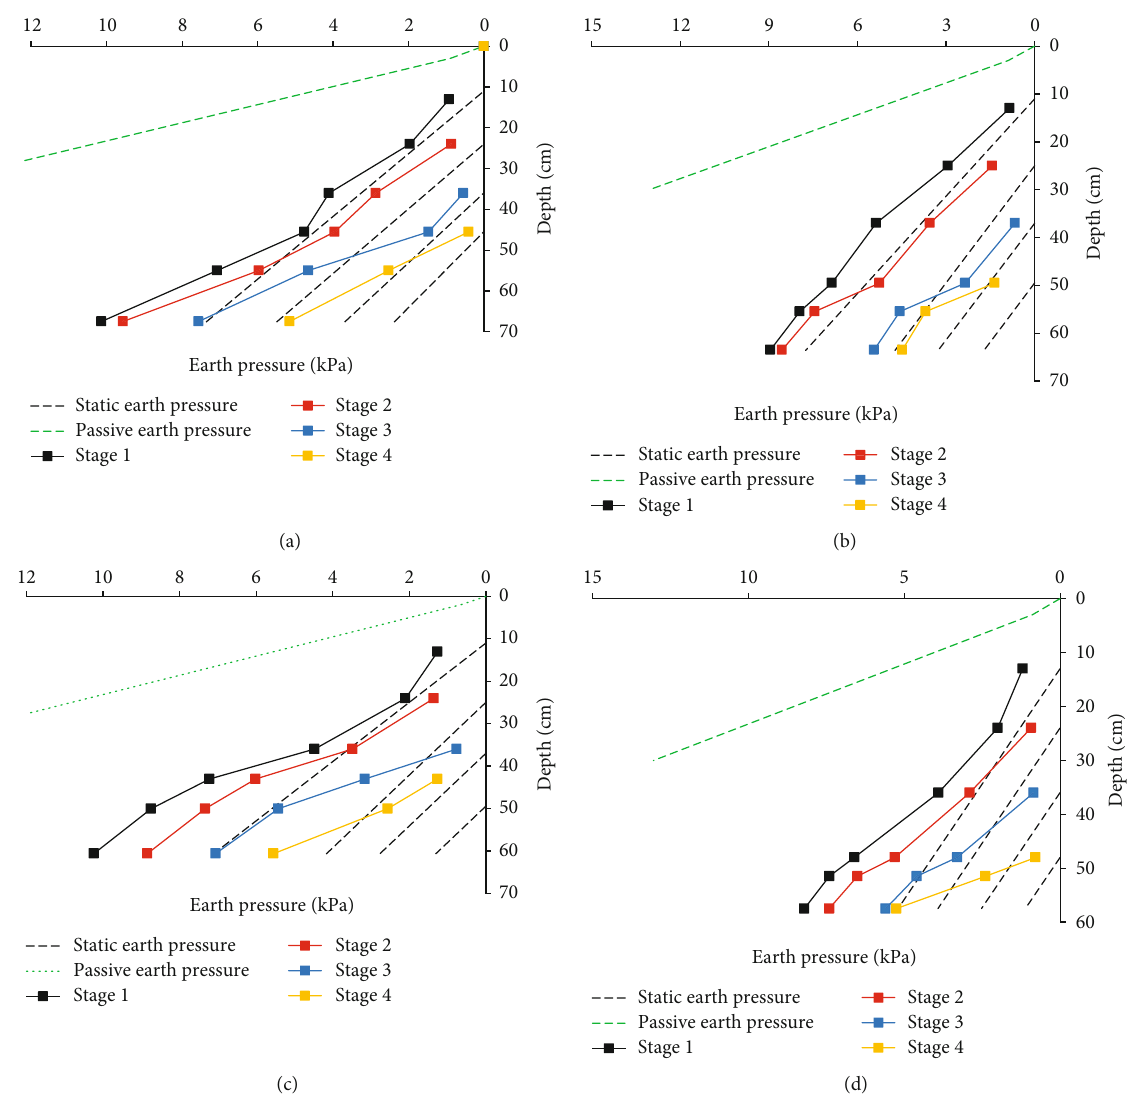
Figure 11: (a) Earth pressure in the front of the wall of 0.41H; (b) earth pressure in front of the wall of 0.33H; (c) earth pressure in front of the wall of 0.27H; (d) earth pressure in front of the wall of